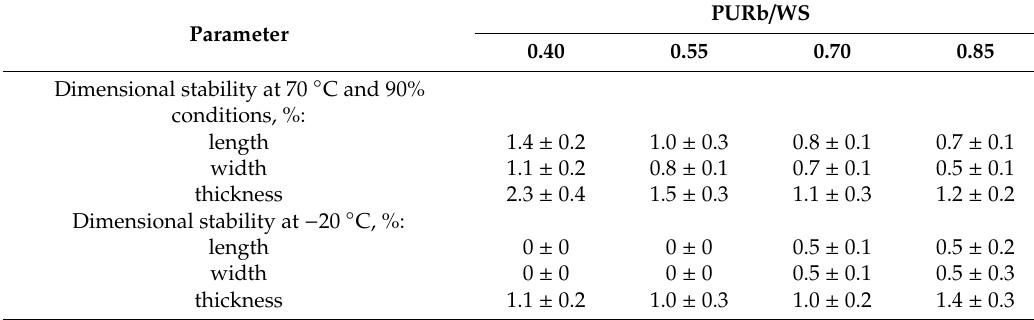
Table 7. Dimensional stability of PUR biocomposite foams with di ff erent PURb / WS ratios. PURb / WS Parameter 0.40 0.55